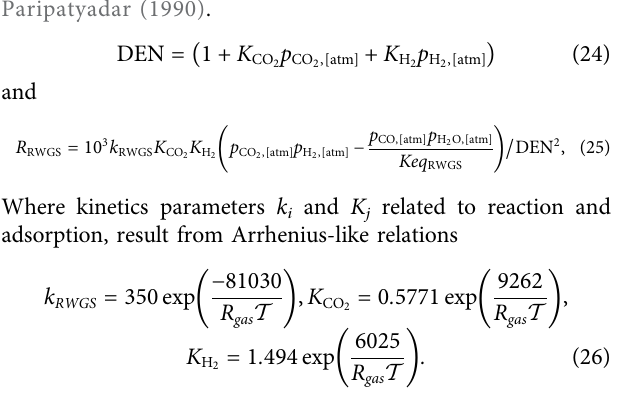
RWGS kinetics are adapted from Richardson and Paripatyadar (1990).